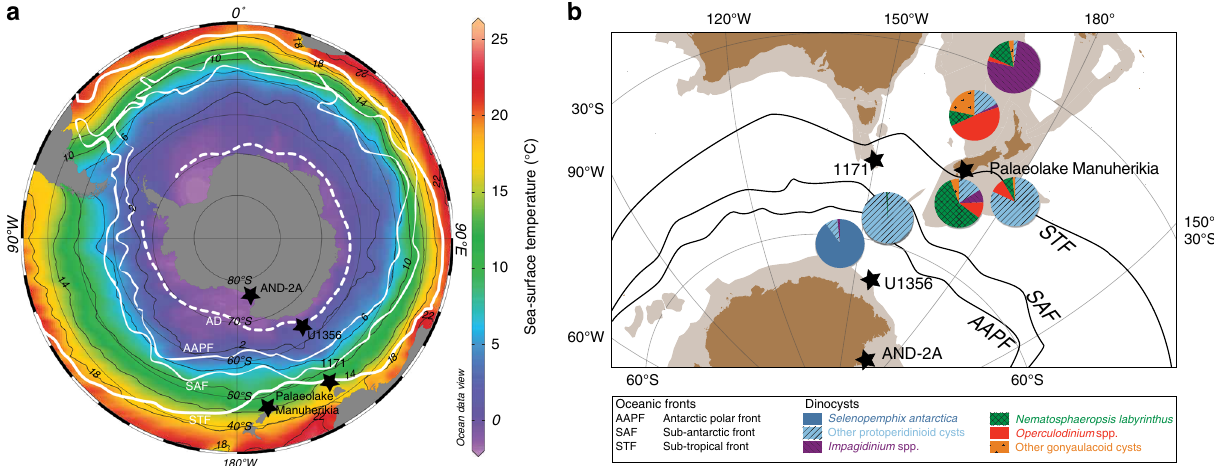
Fig. 1 Modern Southern Ocean surface oceanography and dino fl agellate cyst assemblages. a Surface-water temperatures of the present-day Southern Ocean during summer (Ocean Data View, https://odv.awi.de/) 90,25 , b Dino fl agellate cyst assemblages in surface samples across the southwest Paci fi c sector of the Southern Ocean as derived by Prebble et al. 32 . Black lines schematically represent oceanic fronts 91 and black stars indicate the locations of IODP Site U1356 (Wilkes Land) 24 , AND-2A (Ross Sea) 27 , ODP Site 1171 (South Tasman Rise) 9 , and Palaeolake Manuherikia (New Zealand) 28 . STF Subtropical Front, SAF Subantarctic Front, AAPF Antarctic Polar Front, AD Antarctic Divergence. Landmasses are indicated in brown, continental lithosphere in light brown in the location map. Data are derived from Gplates freeware (www.gplates.org; version 1.5.0). We use the plate circuit of ref. 92 and the absolute rotation path (based on palaeomagnetism) of the African plate from ref. 93 in our reconstructions (see ref. 46 for additional